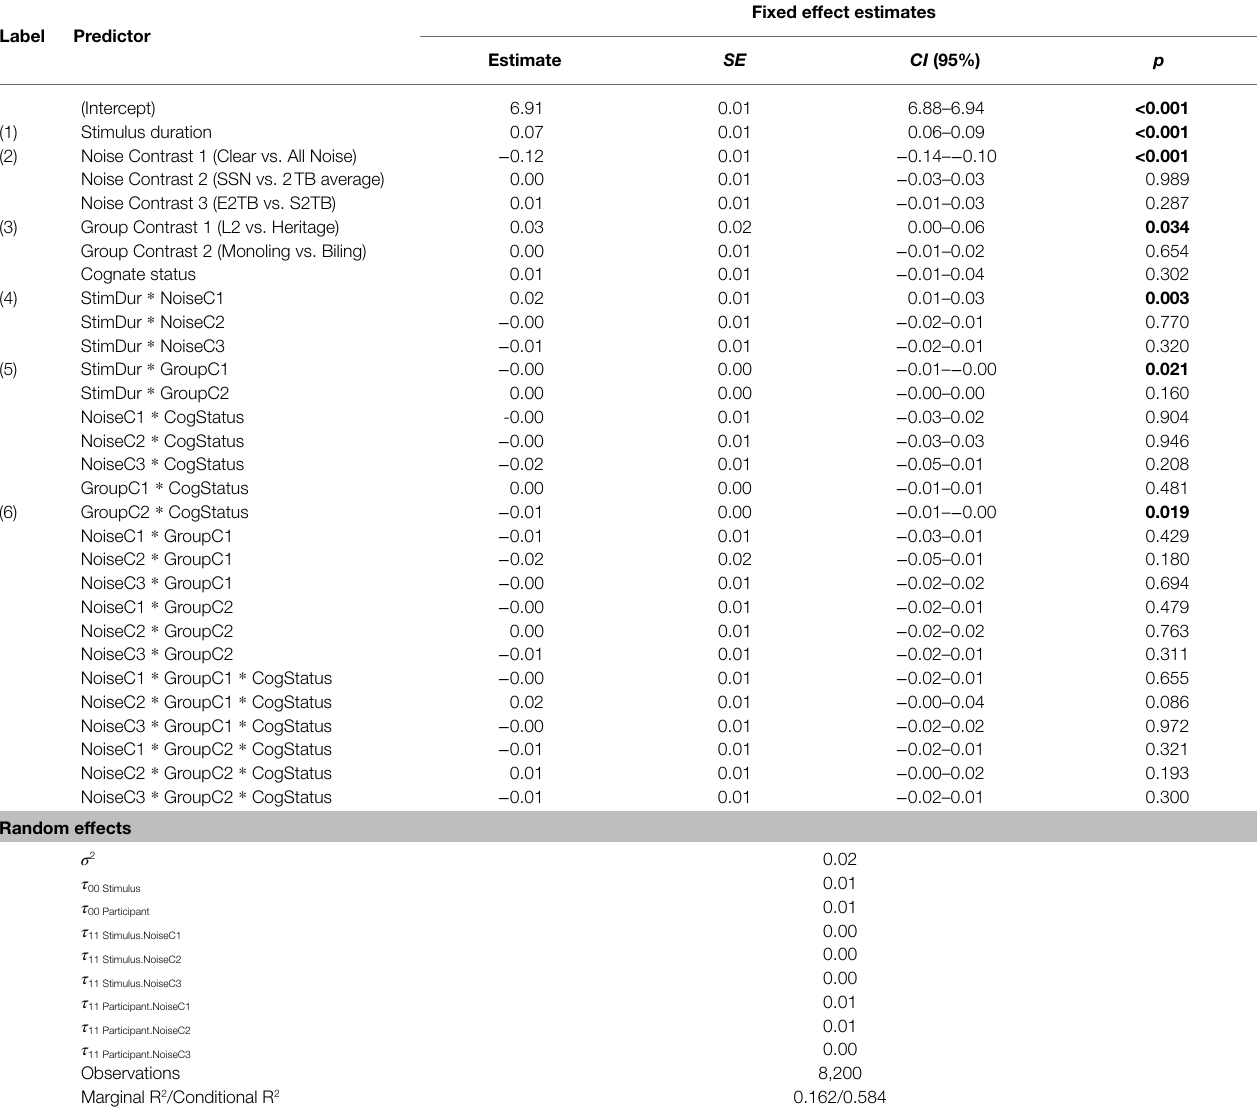
TABLE 4 | Fixed and random effects for the model comparing RTs across participant groups.